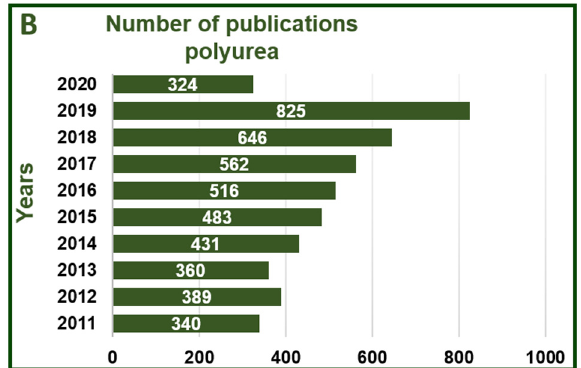
Figure 4. Articles published in the last 10 years related to: ( A ) polyurethanes; and ( B ) polyurea. These numbers were generated from the “Web of Science database” using the keywords “polyurethanes” for ( A ), and “polyurea” for ( B ). (Date data acquired: 15 July 2020).